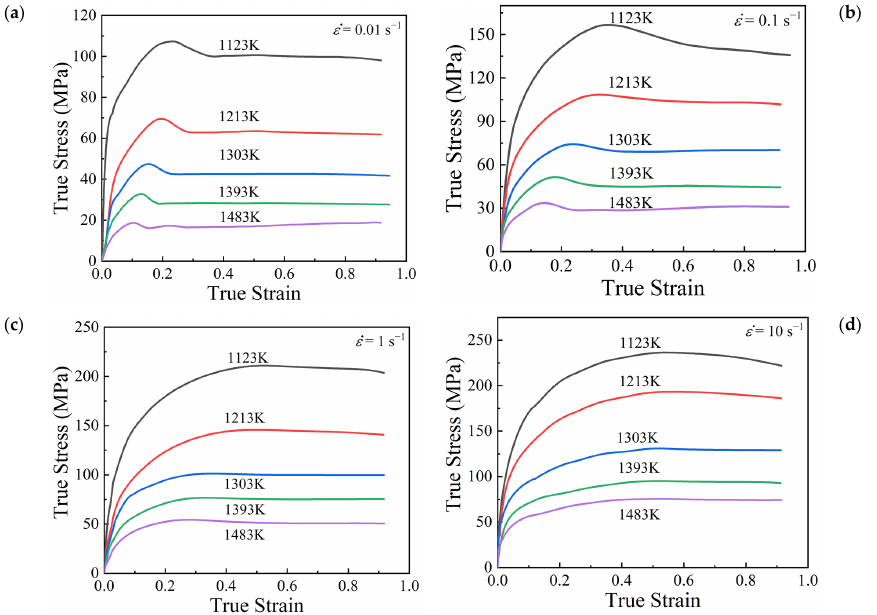
Figure 4. True stress–strain curves of SAE 5137H steel under temperatures of 1123–1483 K and different strain rates: ( a ) 0.01 s − 1 , ( b ) 0.1 s − 1 , ( c ) 1 s − 1 , ( d ) 10 s − 1 .